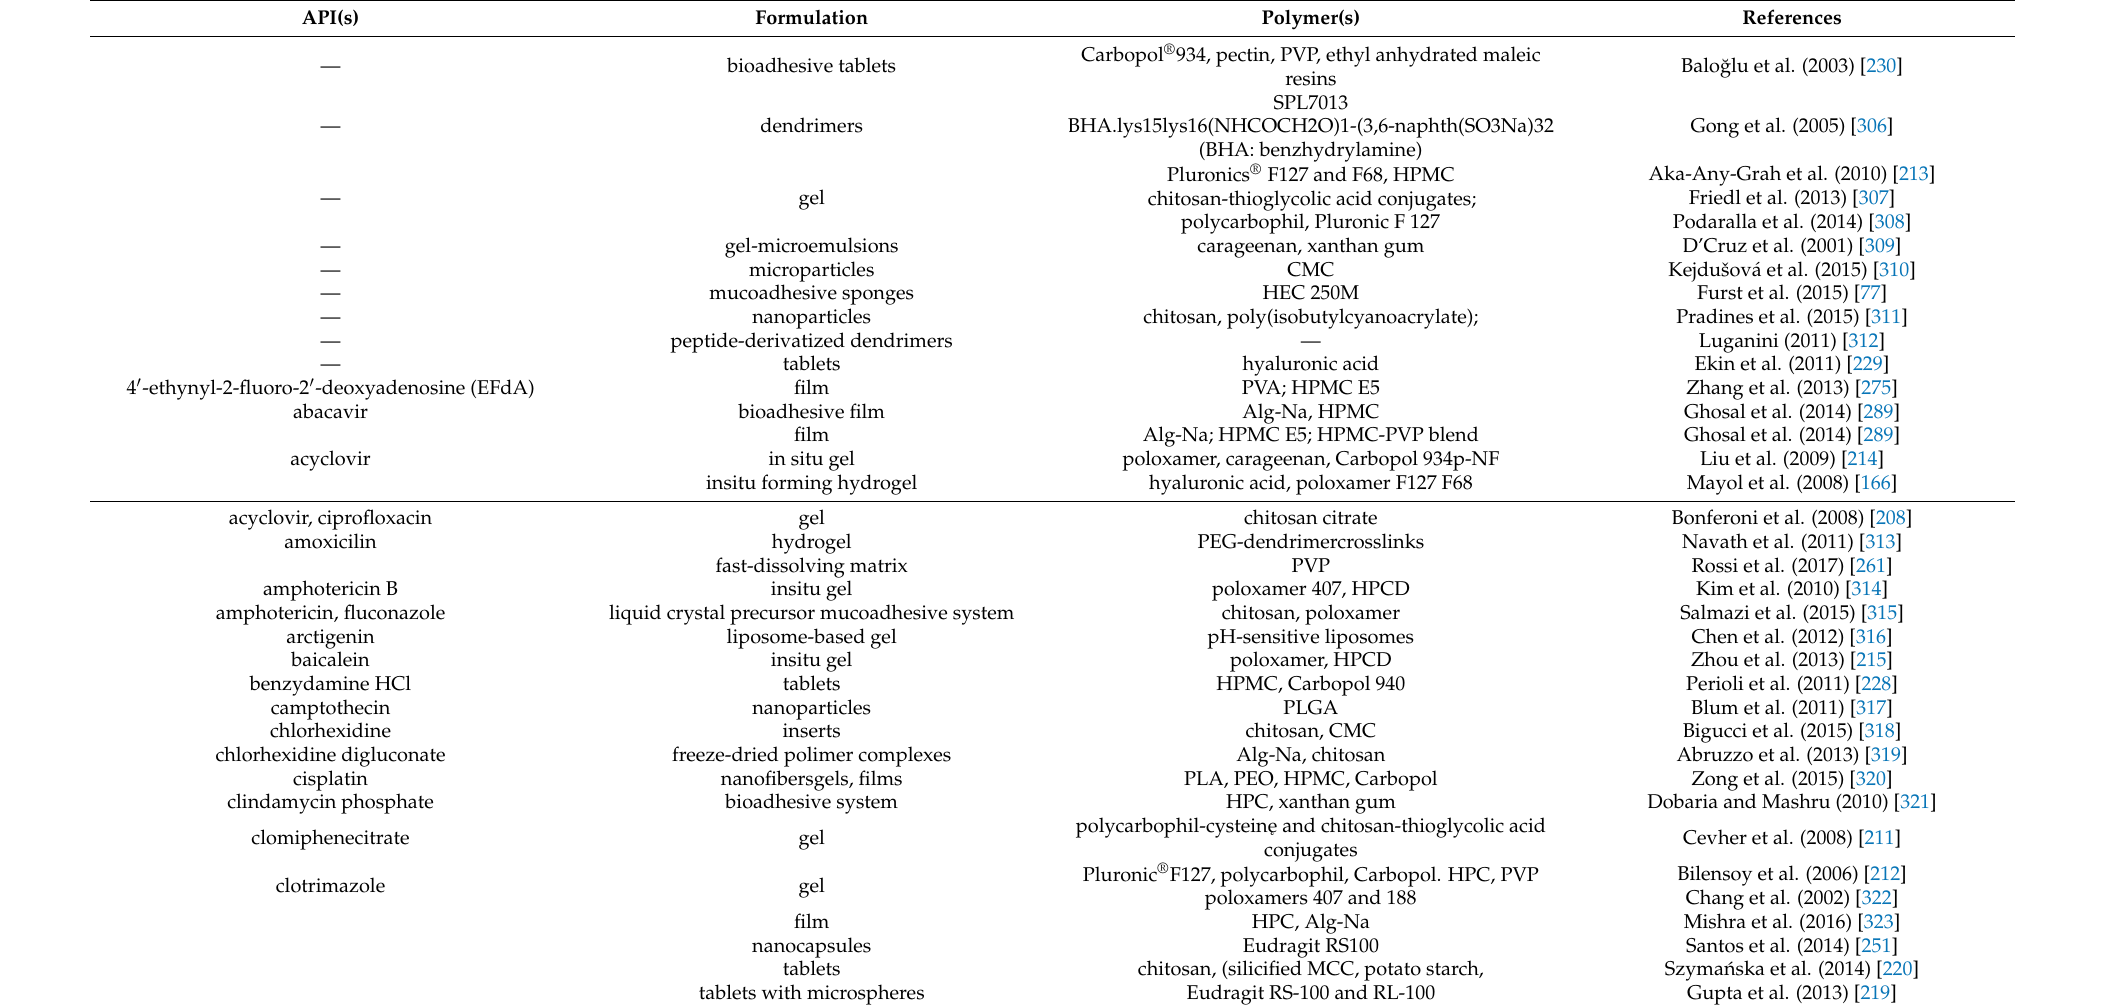
Table 1. Polymer-based vaginal